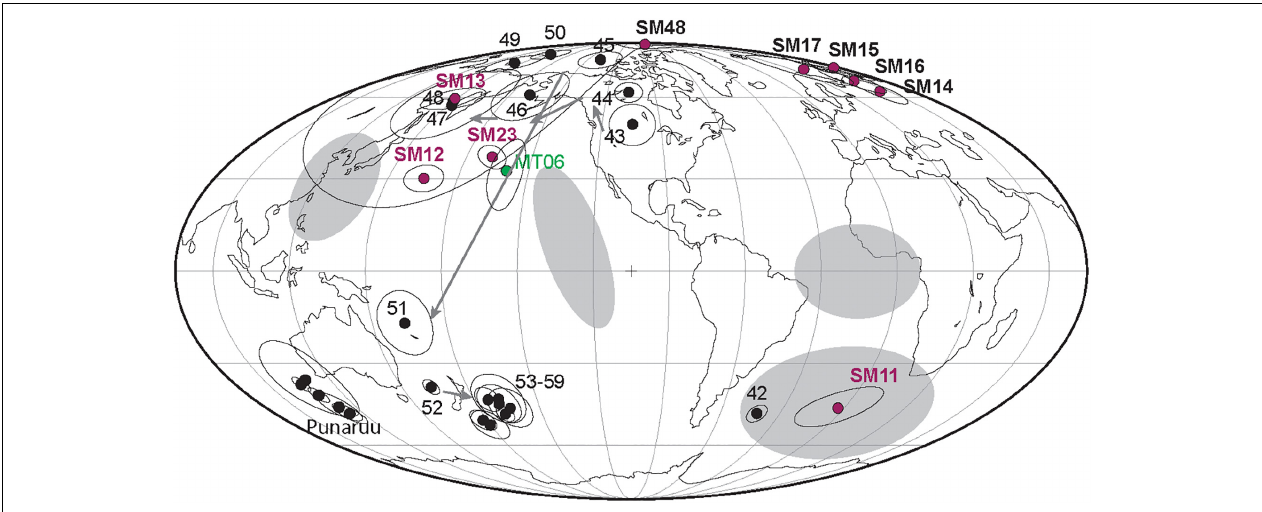
FIGURE 6 | Virtual Geomagnetic Poles of samples dated circa 770 ka from the Maui (Coe et al., 2004), Martinique (Tanty et al., 2015), Tahiti (Chauvin et al., 1990), and Azores volcanic sequences that recorded the last reversal. Gray areas indicate the locations of the VGP groups from site U1306 sediments in North Atlantic Ocean (Channell,